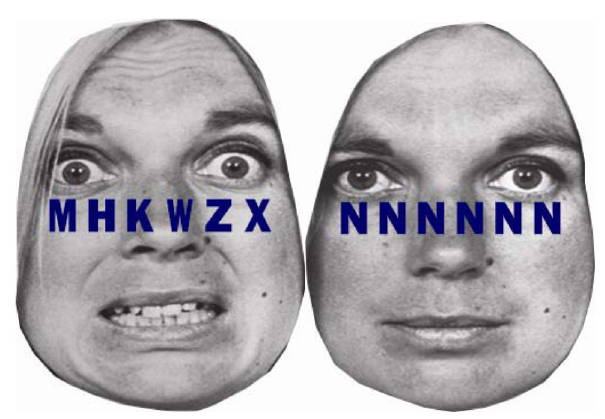
FIGURE 4 | Example stimuli from Park etal. (2013a, 2014). A string of six letters was superimposed on fearful and neutral facial emotions. In the high cognitive load condition, letter strings consisted of one target letter and five non-target letters (H, K, M,W, or Z) arranged in random order (left). In the low cognitive load condition, the letter string consisted of six X’s or six N’s